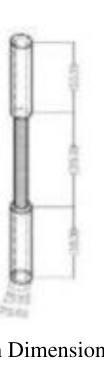
Figure 16. Specimen Dimension (Author’s own,